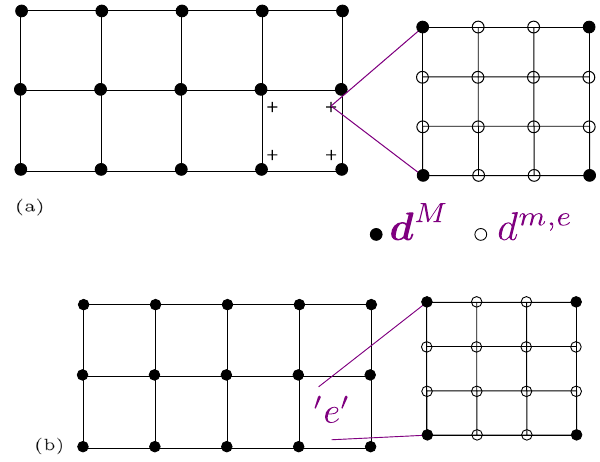
Fig. 4 Model FE 2 for a three-point bending test, with a finite ele- ment mesh composed of Q 4 isoparametric elements at macro-scale and another mesh of Q 4 elements constructed at micro-scale: a FE 2 method with micro-scale mesh constructed at each Gauss point of macro-scale element; b proposed method [41] with micro-scale mesh constructed for each macro-scale element—mesh-in-ele- ment